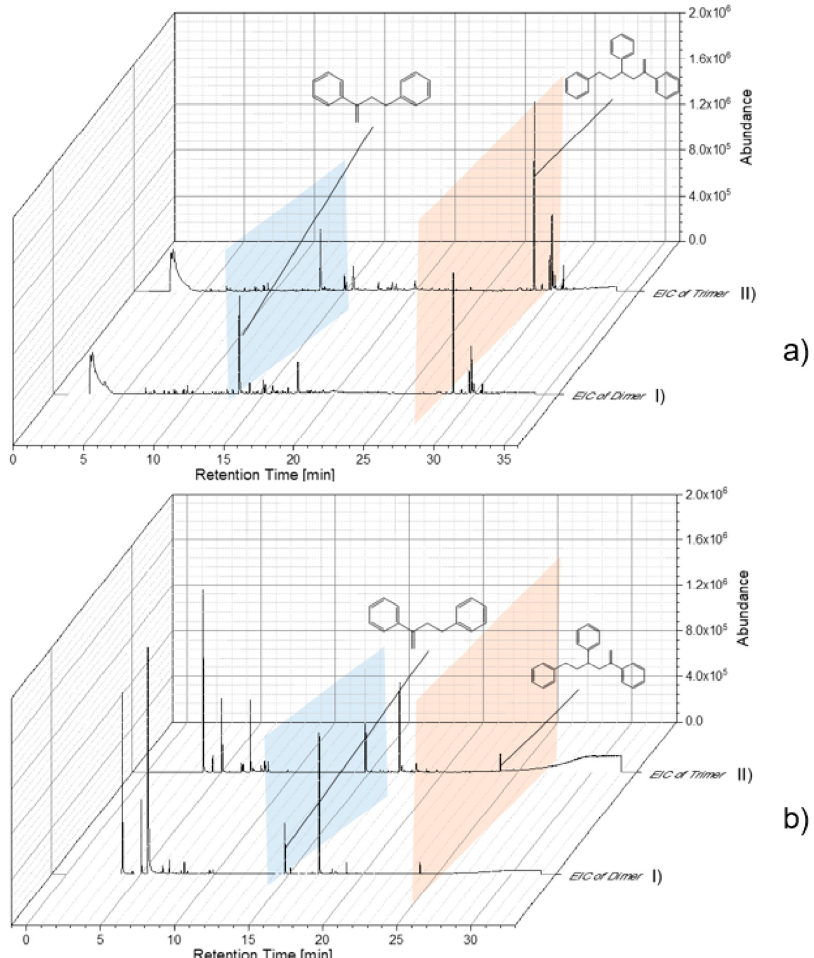
Figure 12. Chromatogram/pyrogram analysis of PS 78-nm particles using extracted-ion chromatography (EIC) for dimer (I) and trimer (II): ( a ) TD-chromogram (TD-GC/MS), ( b ) pyrogram (Pyr-GC/MS). Ref [132] Reproduced with permission from Reichel et al., Molecule; published by MDPI, 2020.